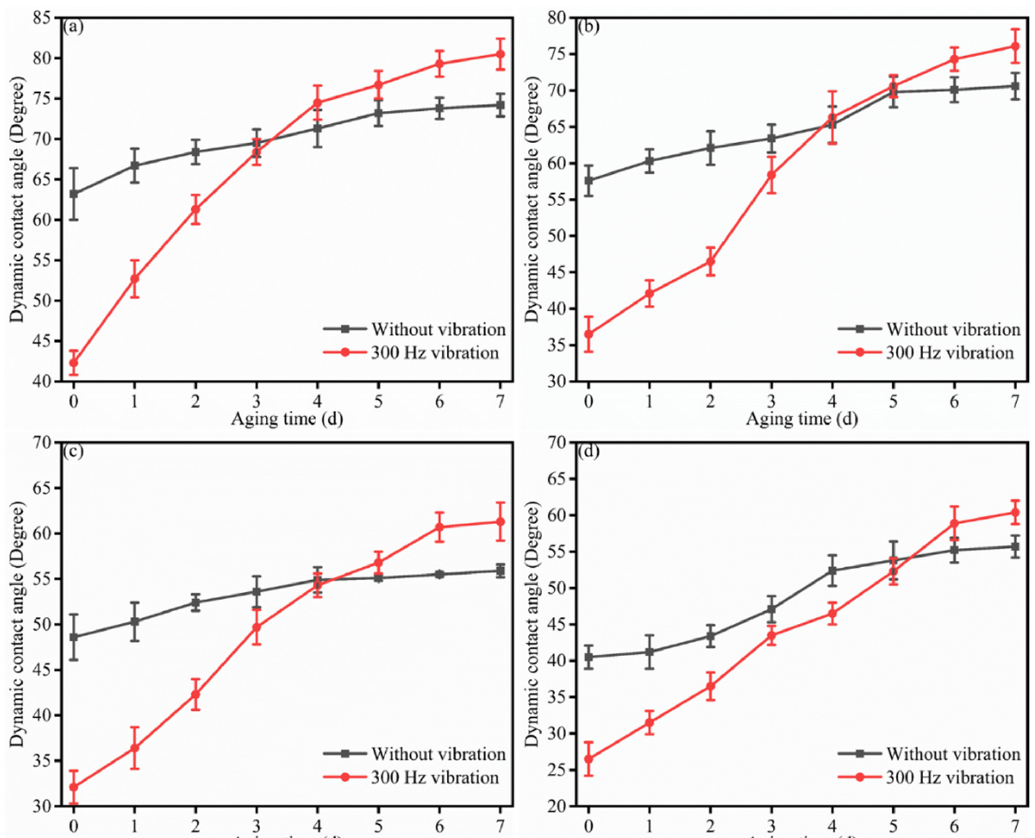
Figure 9. The static contact angles of sewage water drops onto the ( a ) iron casting; ( b ) steel; ( c ) PVC; ( d ) PE, with or without 300 Hz vibration with different aging time.